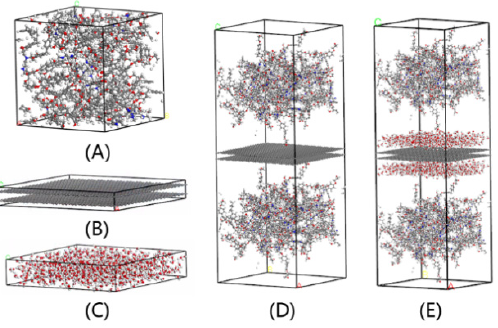
Figure 3. Molecular models of epoxy resin and its composites. ( A ) pure epoxy resin model consists of 15 represented units; ( B ) multi-layers graphene; ( C ) water molecule; ( D ) water layer; ( E ) initial model of epoxy resin enhanced by multi-layers layers graphene; and ( E ) initial enhanced system consisting of water molecules.